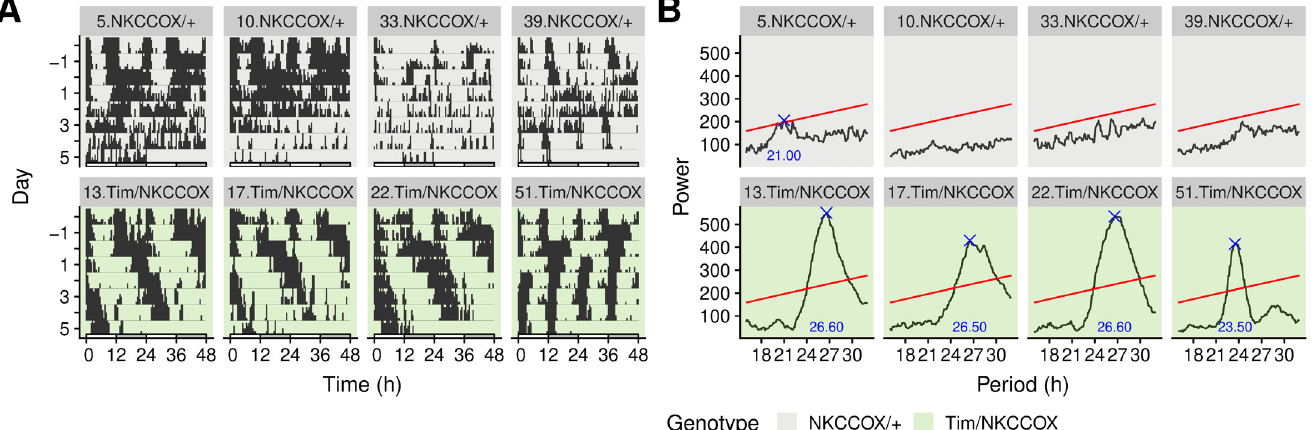
Fig 4. Visualisation of the periodicity in the activity of eight selected animals. A: Double-plotted actograms showing all activity during experiment. Time is defined relative to the transition from LD to LL (at day 0). B: χ 2 periodograms over the LL part of the experiment matching the animals in A. The blue cross represents the highest peak (if present) above the significance threshold, at α = 0.05, (red line). Titles on top of each facet refer to the label allocated to each individual. See S2 Fig for all 53